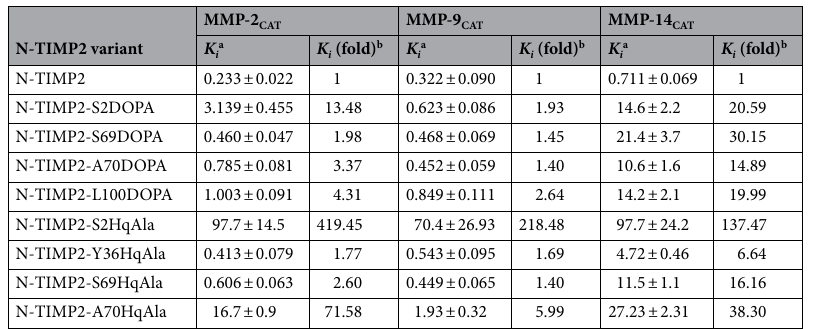
Table 1. Inhibition constants ( K i ) for N-TIMP2 variants binding to the different MMPs. a K i values (nM) were obtained by fitting the data shown in Fig. 5 to Morrison’s tight binding equation. b K i (fold) is calculated as the ratio between the K i of N-TIMP2 variant and the K i of N-TIMP2.